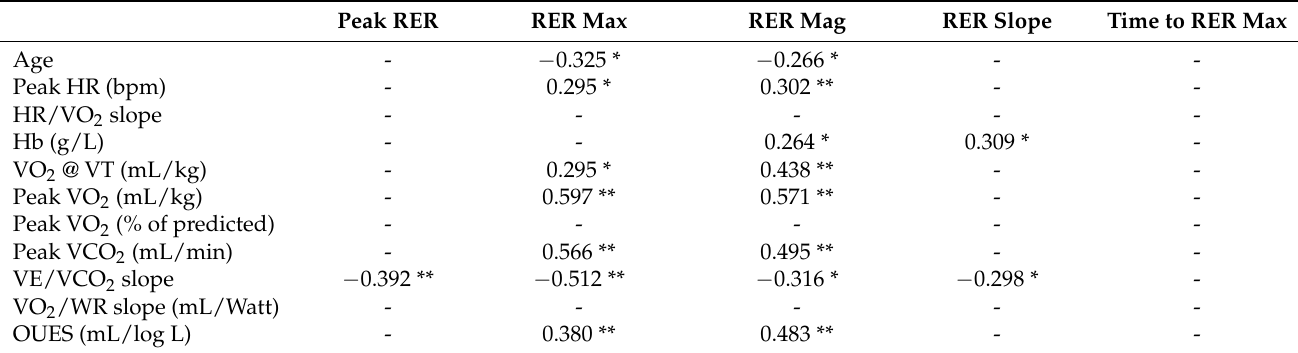
* Correlation significant at the 0.05 level. ** Correlation significant at the 0.01 level. HR = heart rate; VO 2 = oxygen uptake; VT = ventilatory threshold; VCO